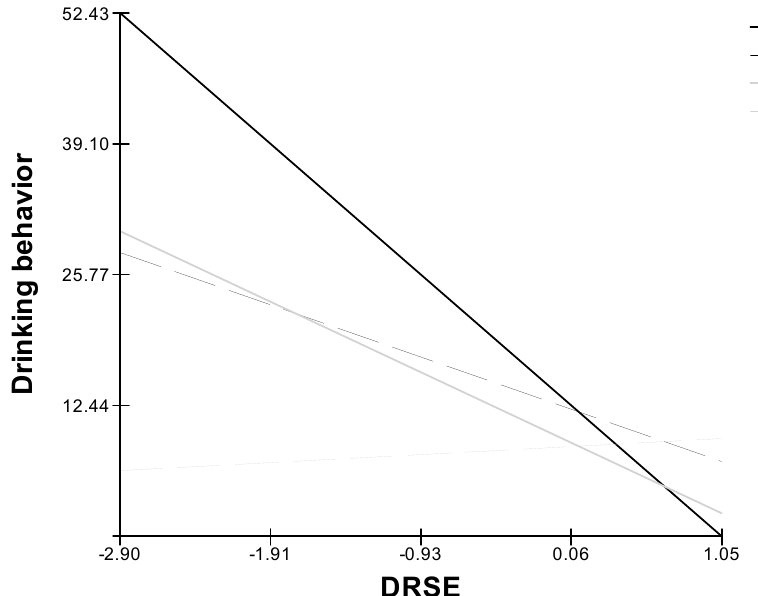
Figure 4. Cross-level three-way interaction effect for drinking behavior (DRSE: Drinking refusal self- efficacy; BPS: Protective behavioral strategies; PEM: Peers’ Enhancement Motivation).